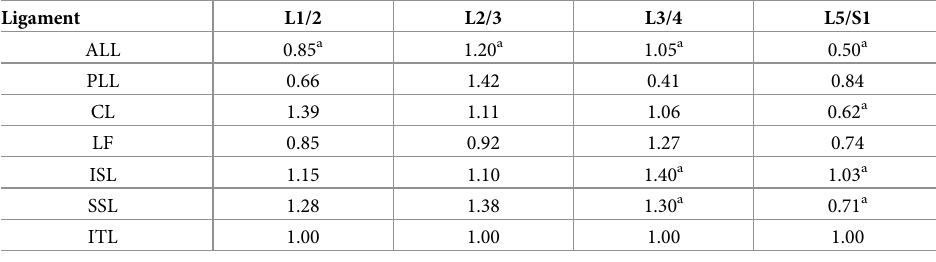
Table 2. Stiffness scaling factors for LSS ligaments [111] with respect to L4/5 level.